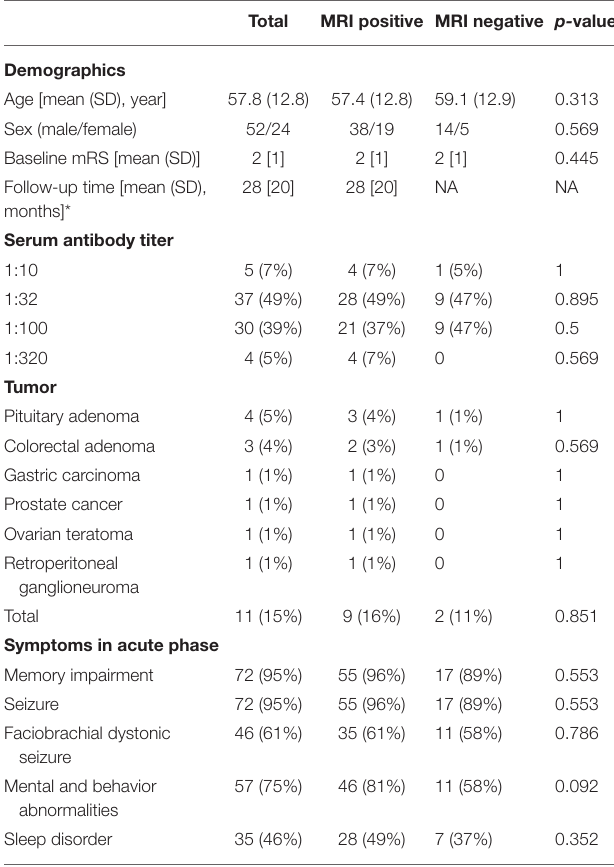
of 1–3 months after onset. In contrast, hypointensity (either on TABLE 1 | Demographic and clinical characteristics of patients with anti-LGI1 encephalitis. T1WI, T2WI, DWI, and FLAIR) and atrophy usually Total MRI positive MRI negative p- value